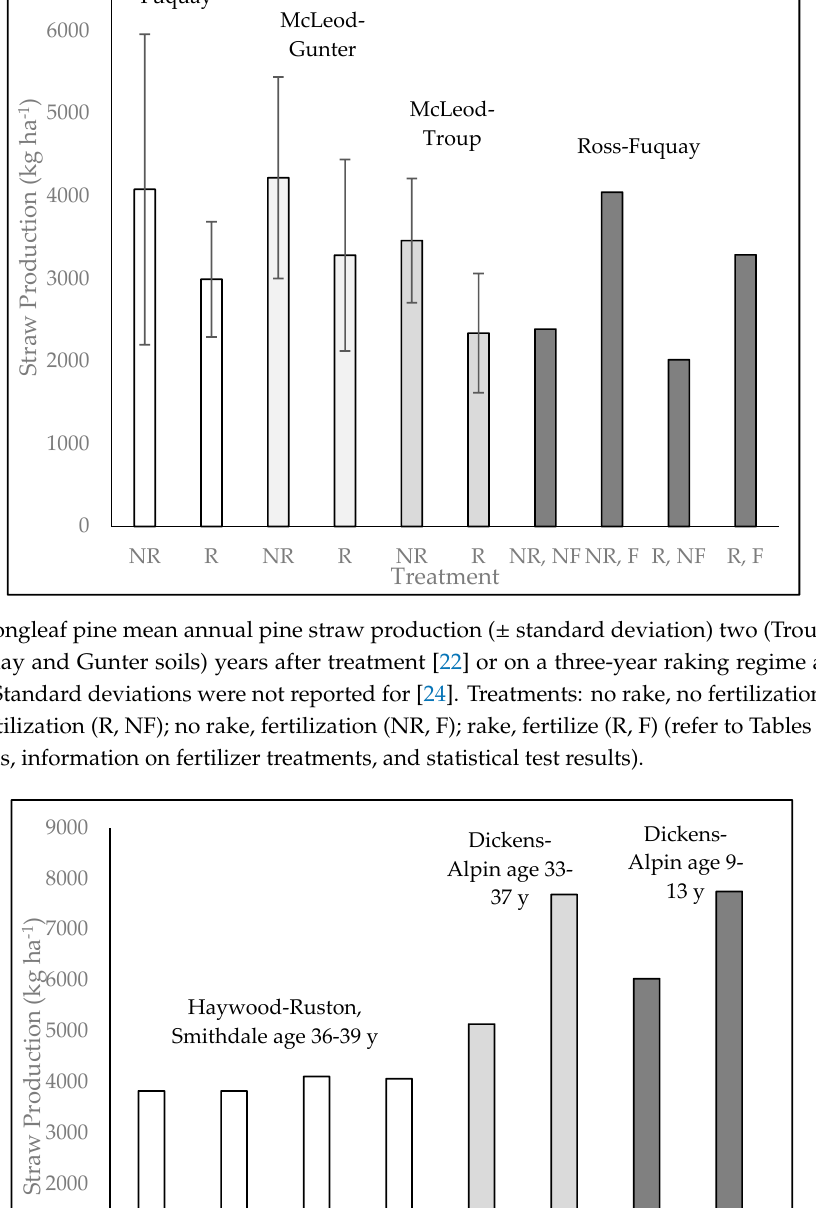
Figure 3. Post-thinning mean annual pine straw production [26] or litterfall over the study period by treatment [27]. Treatments: no rake, no fertilization (NR, NF); rake, no fertilization (R, NF); no rake, fertilization (NR, F); rake, fertilize (R, F) (refer to Tables 3 and 4 for study details, information on fertilizer treatments, and statistical test results).